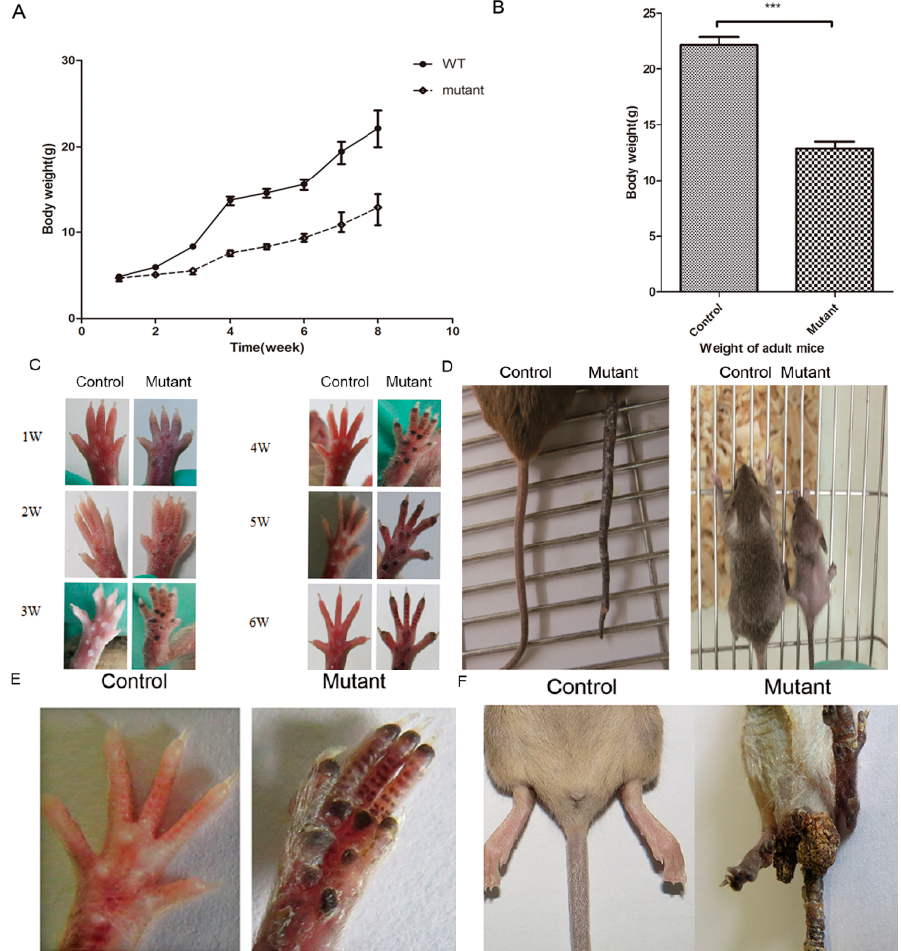
Figure 2. Developmental disorders in epithelial cell–specific Ppp2ca knockout mice. ( A ) Change trend curve of the body weight of Ppp2ca flox/flox ; Krt14-Cre mouse and littermate control groups. n = 6 animals/genotype; ( B ) Body weight of eight-week Ppp2ca flox/flox ; Krt14-Cre mouse and littermate